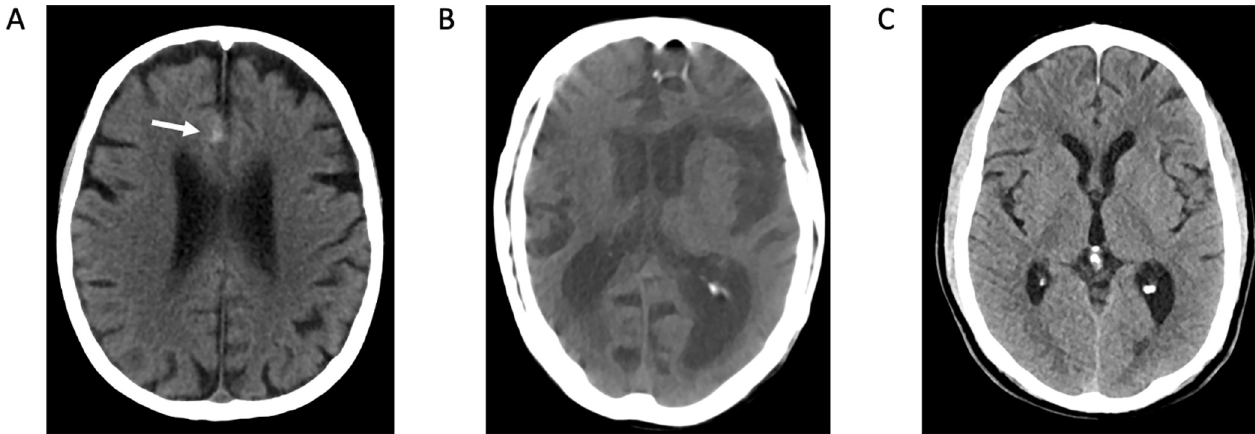
Fig 3. No prediction cases. A: Trace acute subarachnoid hemorrhage along the right anterior cingulate gyrus. B: Noncontrast head CT degraded by motion artifact. C: Normal noncontrast head CT.